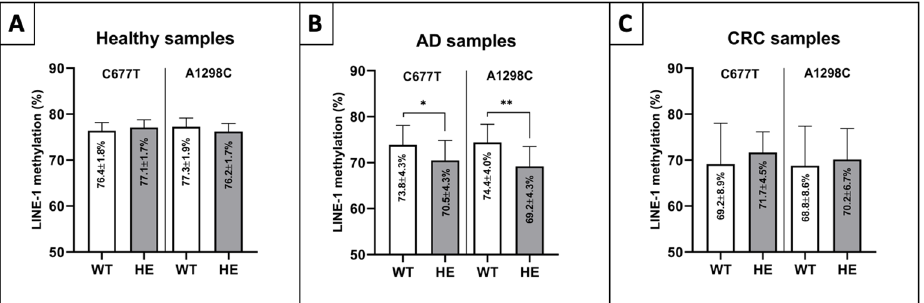
Figure 6. LINE-1 methylation alteration depending on MTHFR status in colorectal tissue samples.